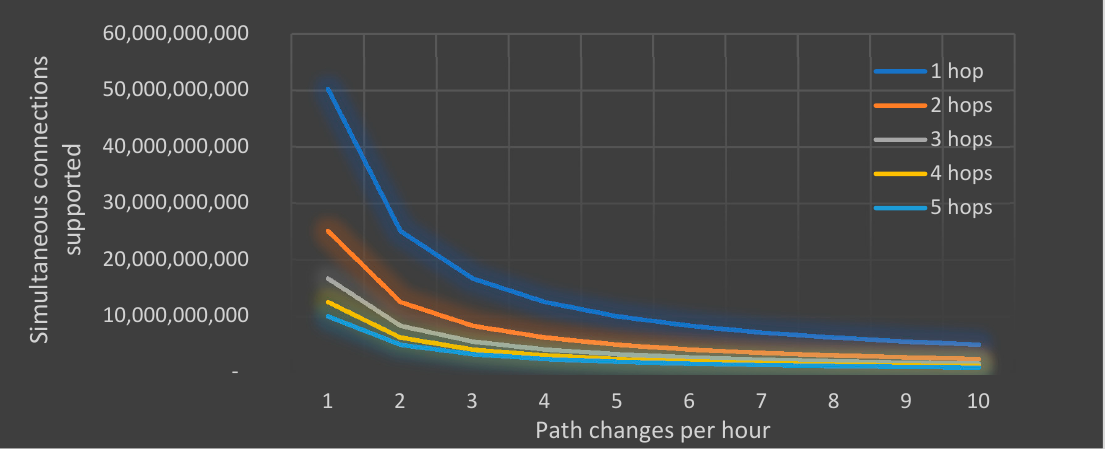
Figure 16. Effect of path instability on the number of simultaneous connections (active State Chan- nels).